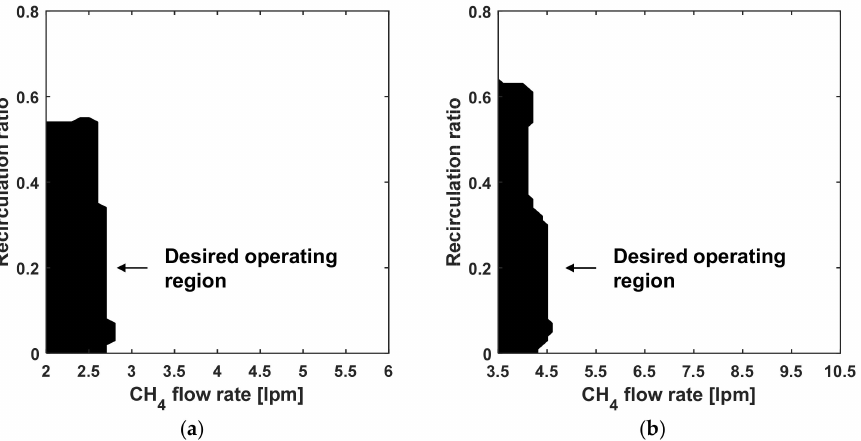
Figure 4. Desired operating conditions of the SOFC system with various fuel flow rates and recircula- tion ratios at operating current densities of ( a ) 0.3 A/cm 2 and ( b ) 0.5 A/cm 2